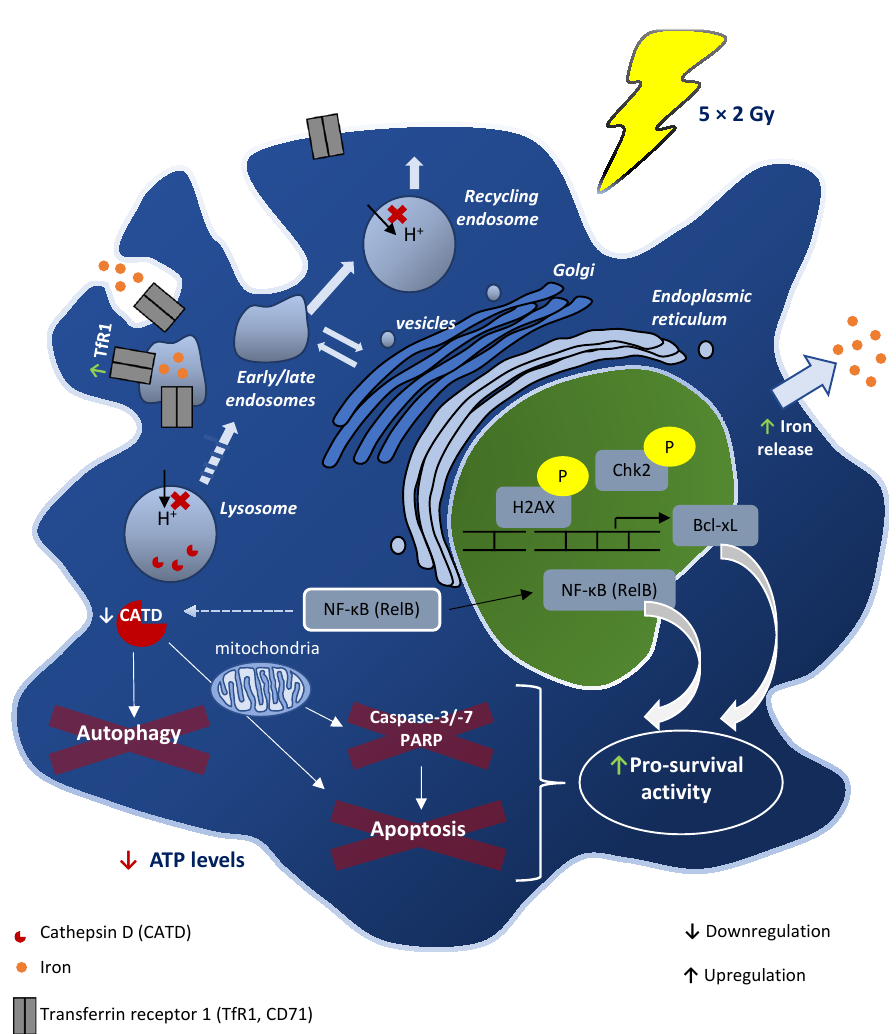
Figure 6. A proposed model for fractionated IR (5 × 2 Gy)-induced effects in human macrophages.